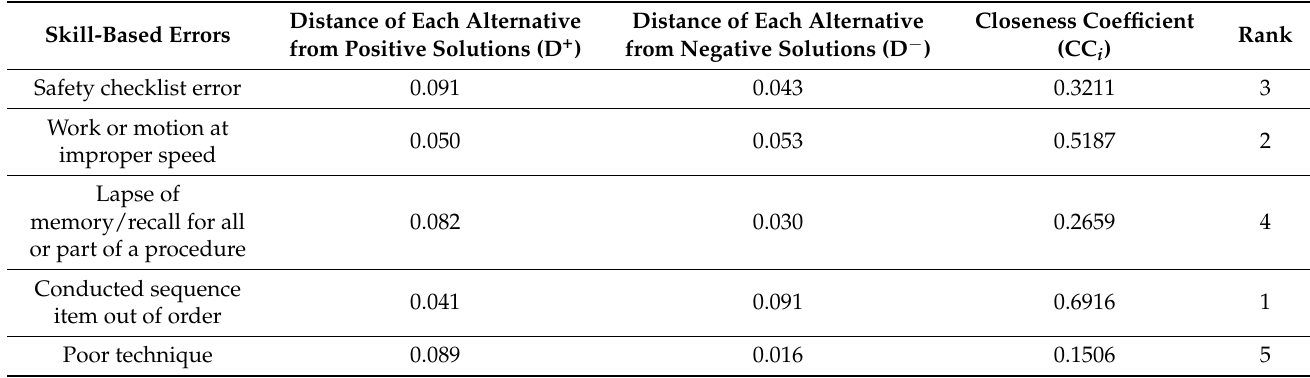
Table 6. Ranks of subfactors for “skill-based errors.”